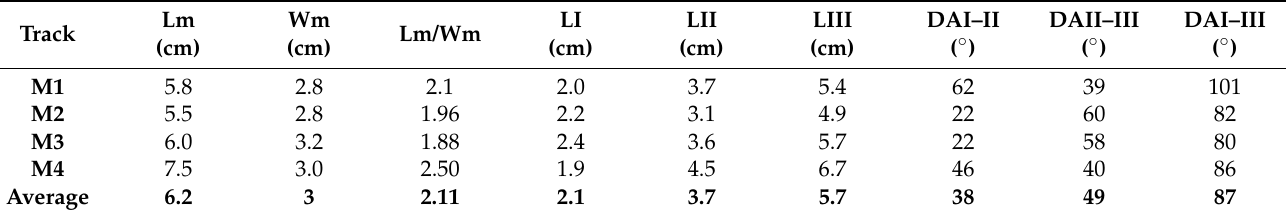
Table 1. Measurements of the pterosaur left manus tracks. Abbreviations as in Section